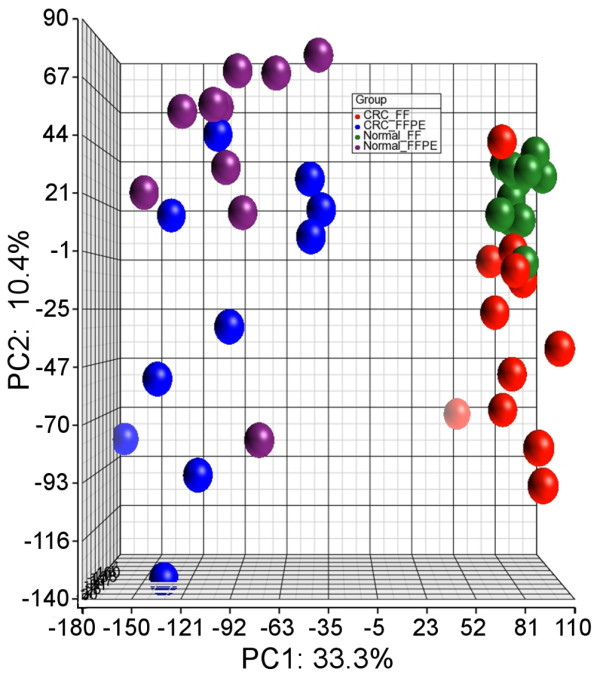
Principle components analysis, displaying spatial separation of: FF tumor tissue (red), FF normal tissue (green), FFPE tumor tissue (blue), and FFPE normal tissue (purple). The color coding suggests that the separation along the horizontal axis (PC1) may be attributed to storage type (FF vs. FFPE), and the separation along the vertical axis (PC2) may be attributed to tissue type (tumor vs. normal).